Question: Give a one-sentence summary of this figure.
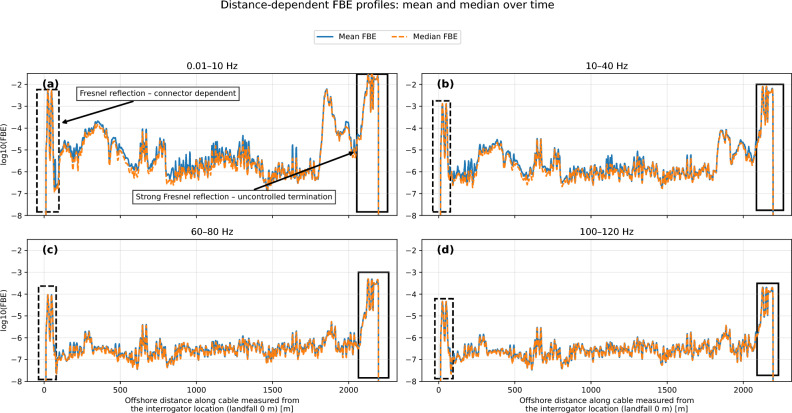
Answer: Distance-dependent profiles of FBE for the EMEC Eday dataset. Solid and dashed curves denote the mean and median FBE over time windows (600 seconds). FBE represents band-integrated spectral power (see Section "Spectral fingerprint construction" and Appendix B ).